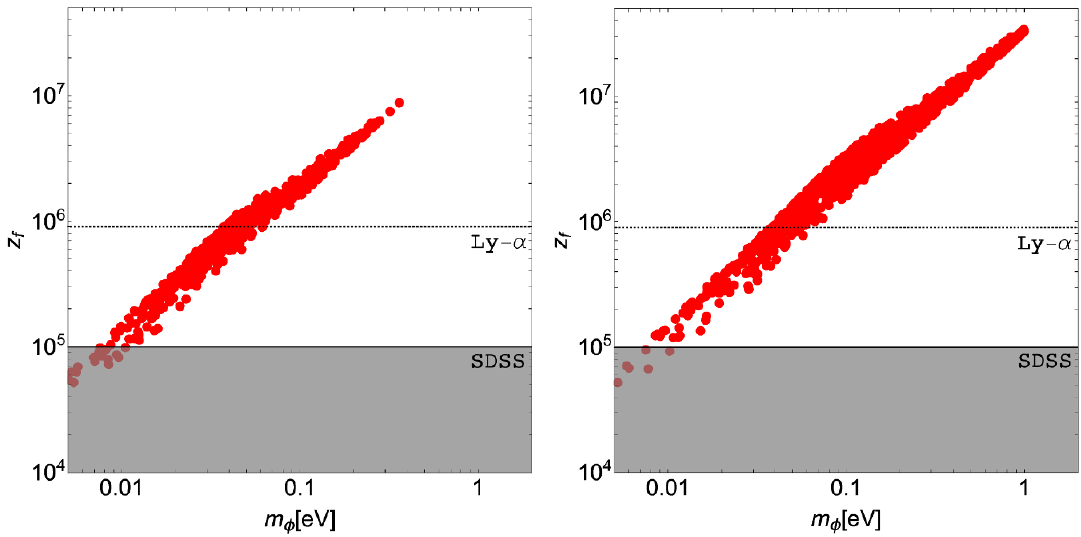
Figure 5 . Scatter plot of z f of the viable region for in(cid:13)ation and dark matter for C = 10 (left panel) and C = 30 (right panel). The light gray region (region below the dotted line) is excluded by the SDSS (Ly (cid:0) (cid:11) )